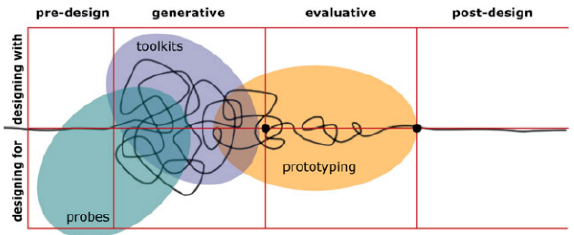
Figure 4: Co-Design research framework (Sanders and Stappers 2014, p.11)